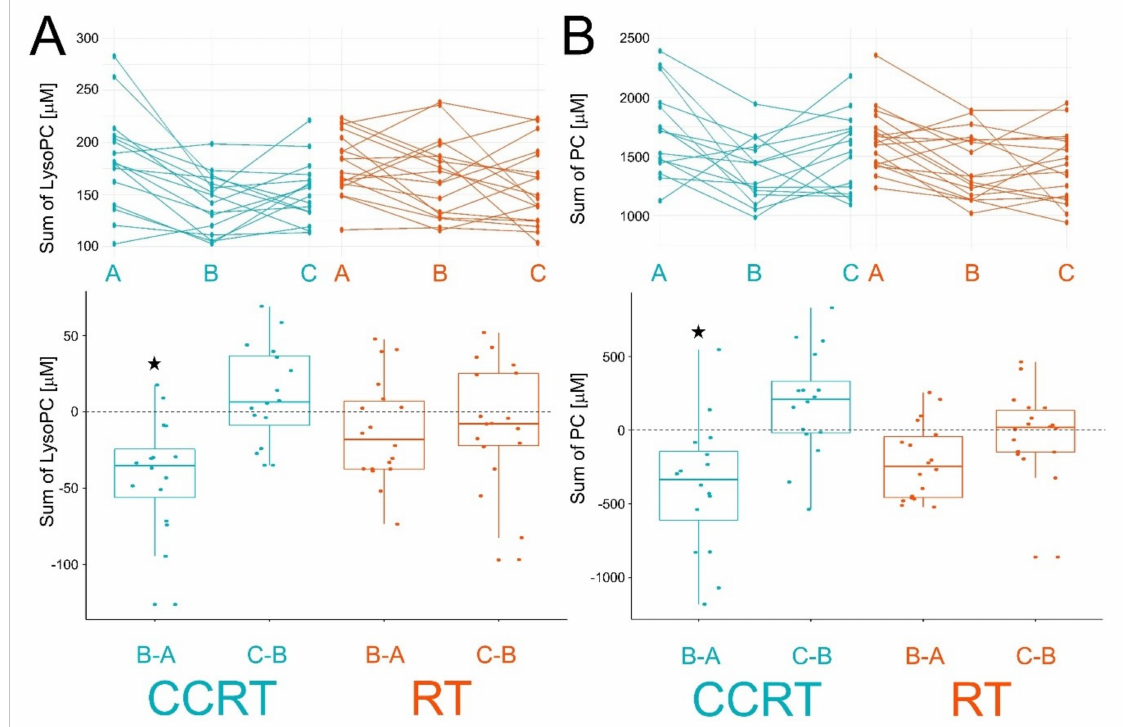
Figure 3. Individual changes of total lysoPC (Panel A) and PC (Panel B) levels between consecutive samples. Showed are time courses of individual levels (upper graphs; samples A, B, and C) and di ff erences between consecutive samples (bottom graphs; changes B-A and C-B). Boxplots show minimum, lower quartile, median, upper quartile, and maximum values; dots represent individual di ff erences; significant change (FDR < 0.05) is marked with asterisks. CCRT samples are marked in blue and RT samples are marked in